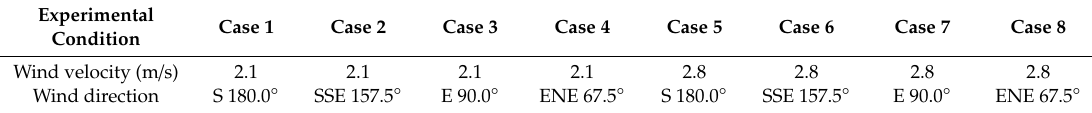
Table 1. Wind tunnel experimental